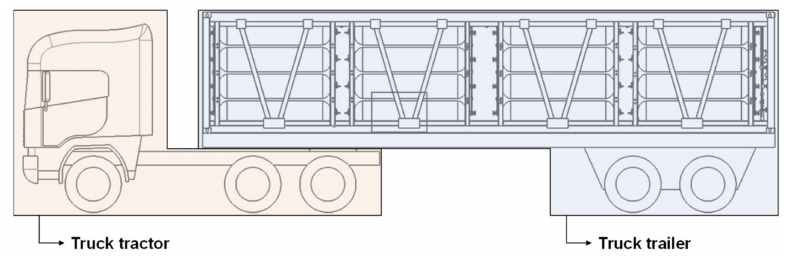
Figure 2. Full car model of the hydrogen tube truck.